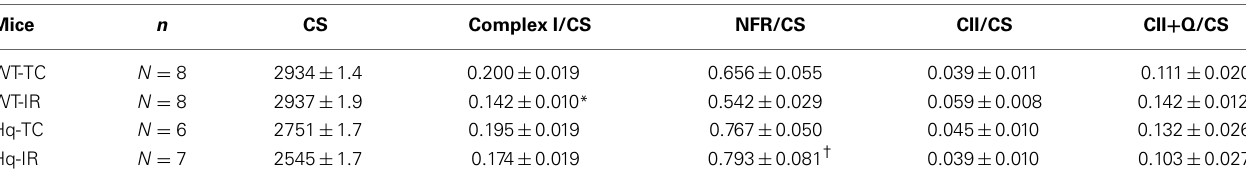
Table 2 | The enzyme activities of Complex I and II in wild type and Hq mitochondria with and without IR. Mice